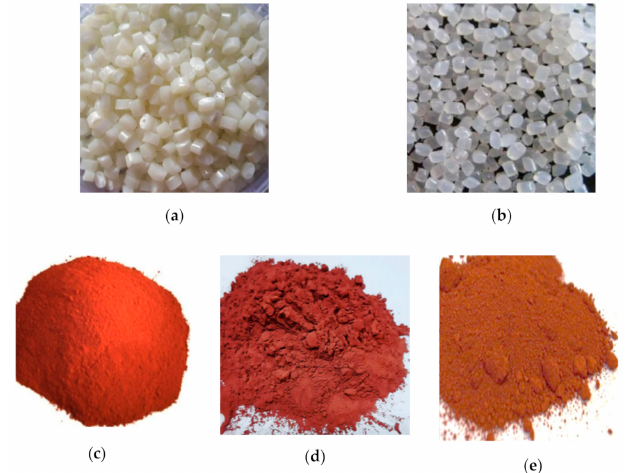
Figure 1. Images of: ( a ) ABS, ( b ) nylon 6, ( c ) 100 mesh copper powder, ( d ) 200 mesh copper powder, and ( e ) 400 mesh copper